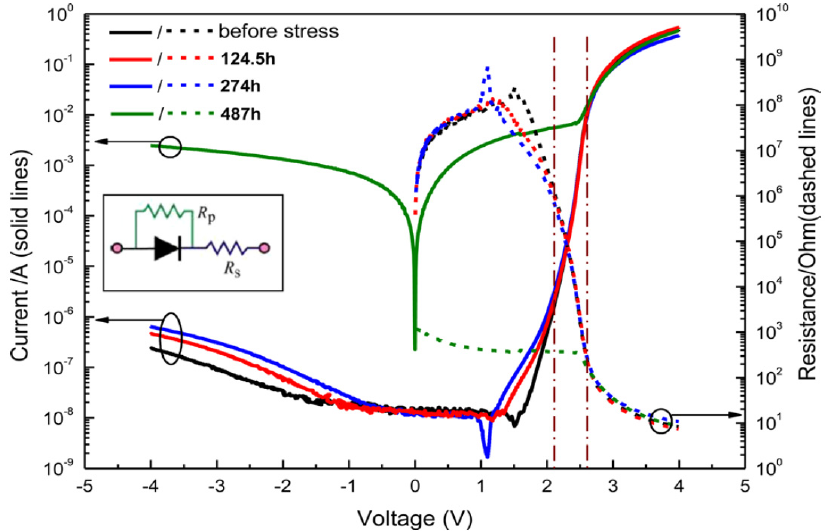
Figure 22. Current-voltage characteristics ( a ) below and ( b ) above the turn-on voltage. Reproduced with permission. [36] Copyright 2018, IOP Publishing.